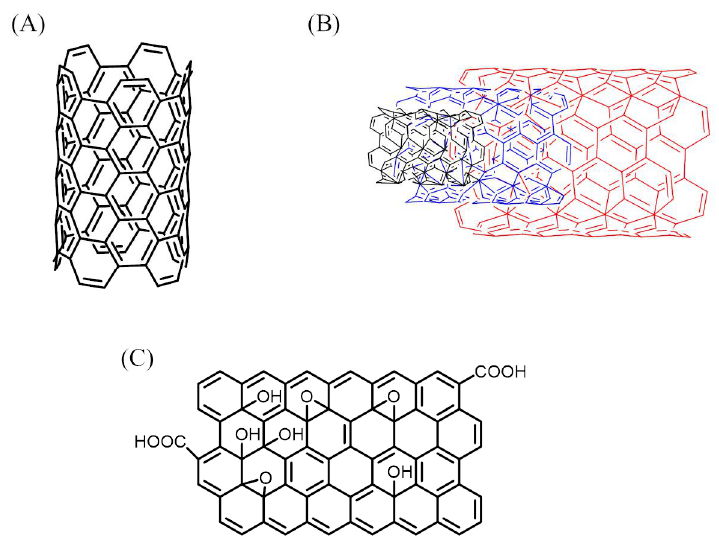
Figure 6. General structure of ( A ) single-wall carbon nanotubes (SWNTs), ( B ) multi-wall carbon nanotubes (MW-NTs), and ( C ) graphene oxide (GO).